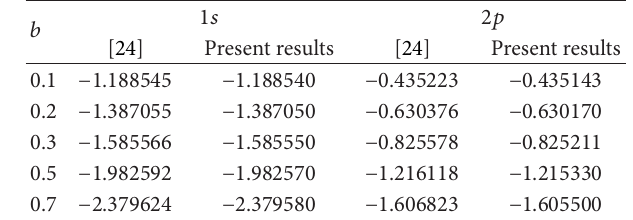
Table 3: When 𝑐 = 0 , 𝑏 ̸= 0 , and 𝜆 = 200 , comparison of 1𝑠 and 2𝑝 Table 2: When 𝑏 = 0 , 𝑐 = 1 , comparison of 1𝑠 energy eigenvalues energy eigenvalues obtained in the present study with results of [24] obtained in the present study with results of [23, 24, 33] for different 1/𝜆 in atomic units. for different 𝑏 screening parameters in Rydberg 1𝑠